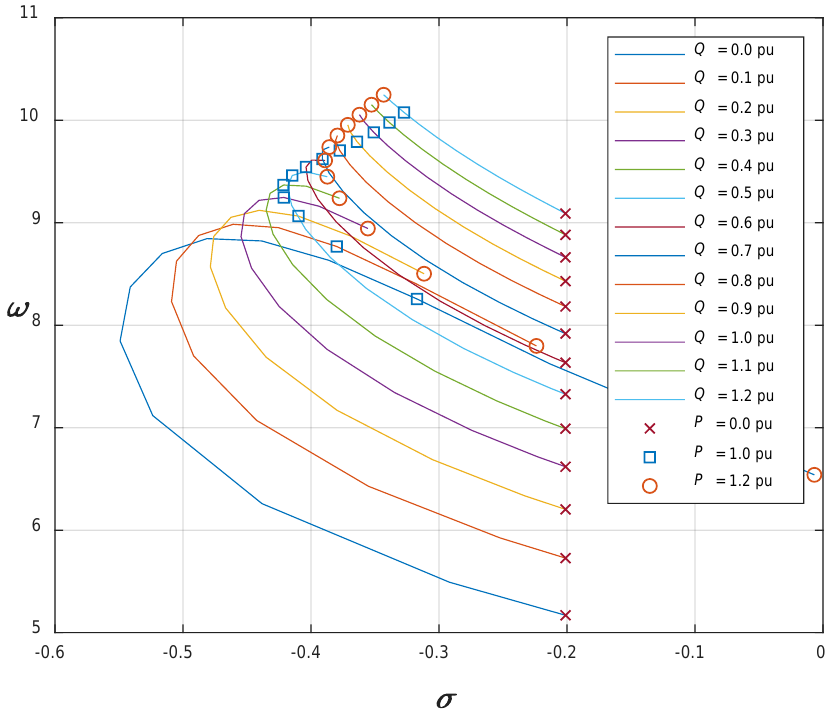
Figure 18. Eigenvalue loci of local mode of 911-MVA turbo-type synchronous generator with AVR.